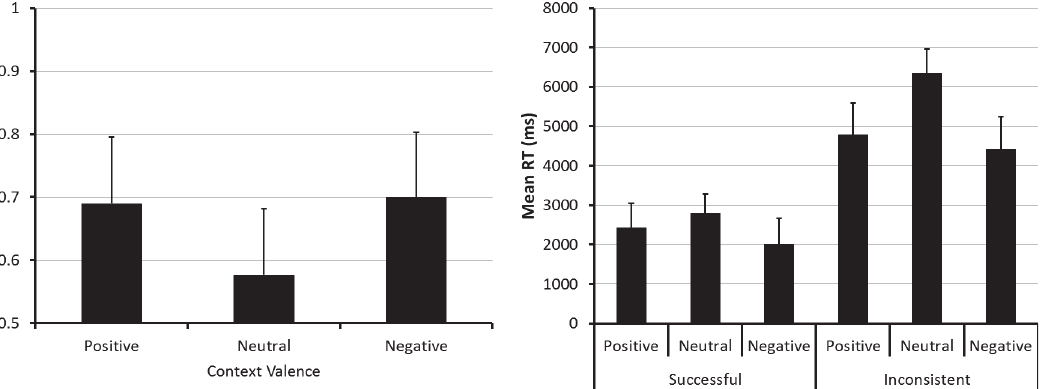
Fig 2. Prospective memory task performance in Experiment 1. The figure shows prospective memory task accuracy (left panel) and speed (right panel) as a function of the valence of the context (positive, neutral and negative) in which the retrieval cues were displayed. The error bars represent the 95% confidence interval for each